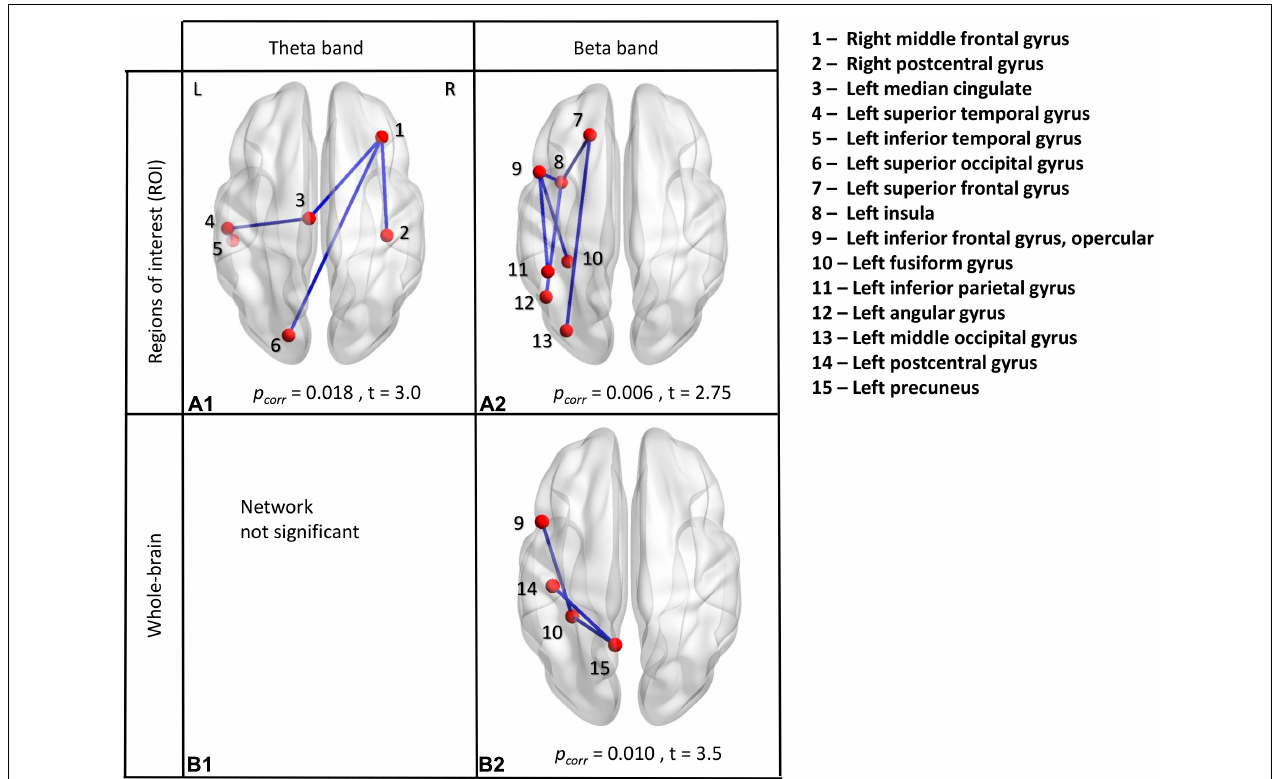
FIGURE 3 | Between-group analyses. ROI analyses in theta frequency band (A1) and beta frequency band (A2) . Whole-brain analyses in theta frequency band (B1) and beta frequency band (B2) . All significant results indicated increased connectivity in the ASD group compared to TD during the presentation of unfamiliar music, measured using amplitude envelope